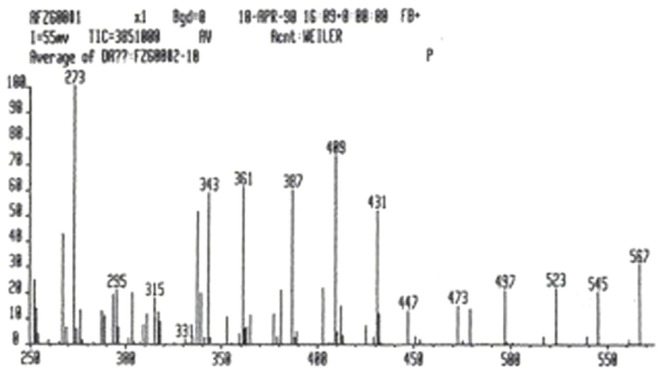
Mass spectroscopy analysis of p-NKAI-1. Note peaks at masses 409, indicating hydrogen adduct, 431, indicating sodium adduct, and 447, indicating potassium adduct. The mass of p-NKAI-1 is, therefore, 408. From Ref. (10) with permission from the editors.